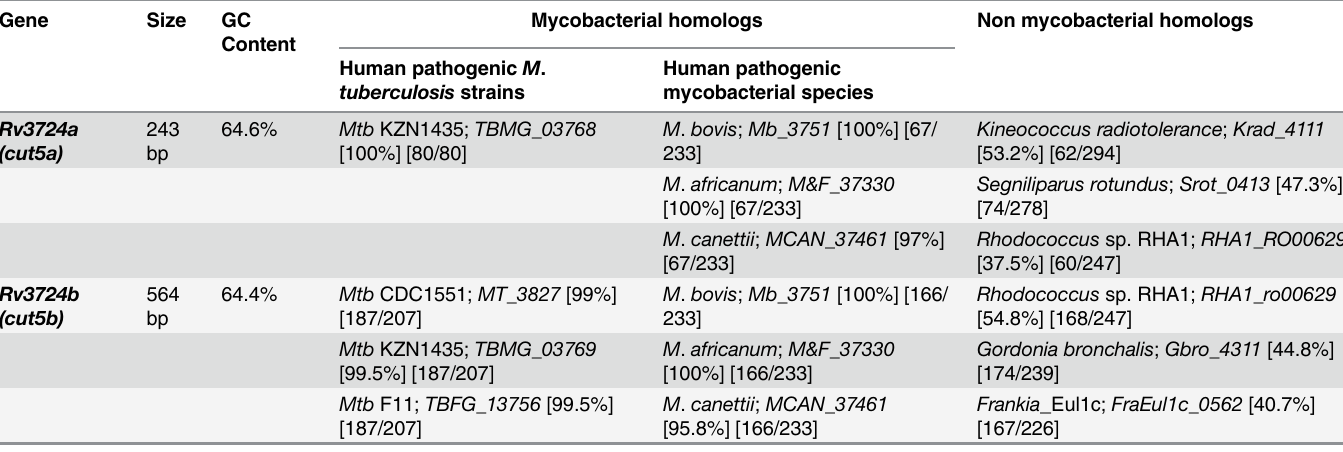
Fig 8. Proposed evolutionary pathway of Rv3724a ( cut5a ) and Rv3724b ( cut5b ) (Panel A) and possible organizations (Org. 1, 2 & 3) of Cut5 protein and its homologs (Panel B) in mycobacteria. doi:10.1371/journal.pone.0133186.g008 Table 2. Homologs of M . tuberculosis H37Rv Cut5a/Rv3724a and Cut5b/Rv3724b present in various mycobacterial and bacterial